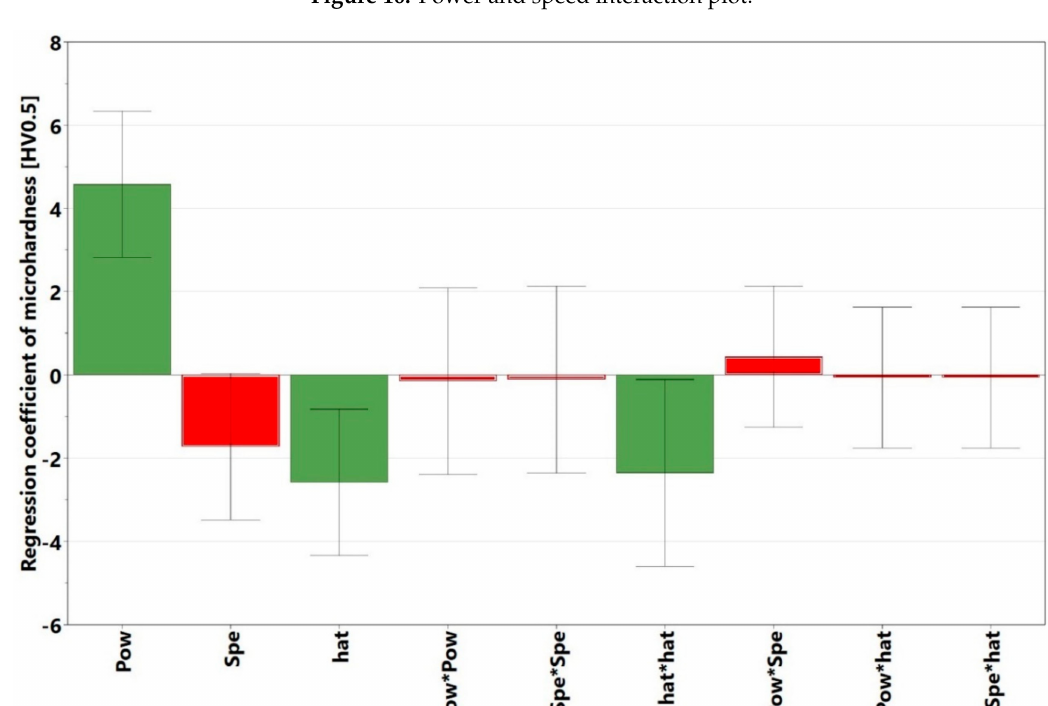
Figure 16. Power and speed interaction plot.